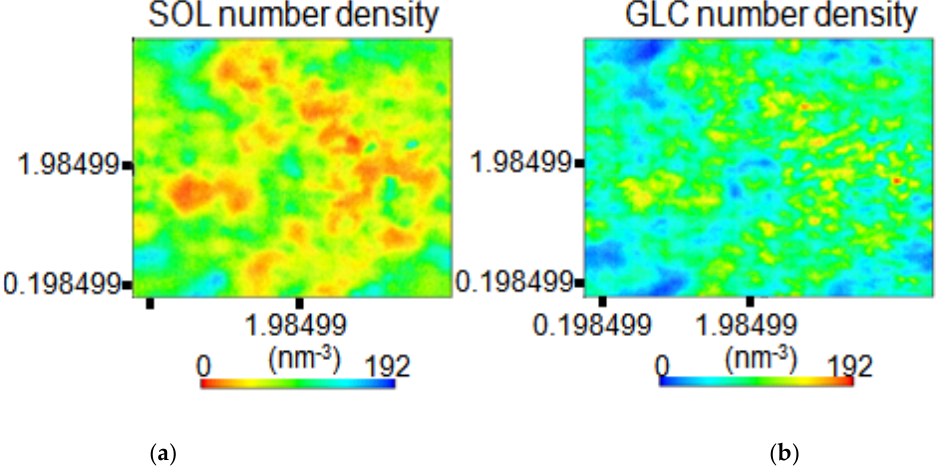
Figure 7. Density maps (number of molecules/nm 3 ) showing ( a ) water molecule distributions and ( b ) amylose at P = 1.0 bar and T = 198.15 K (in the interlayer at d = 001 spacing) for the amylose–H 2 O system. The results were obtained by averaging over 2.0 ns of simulation time.